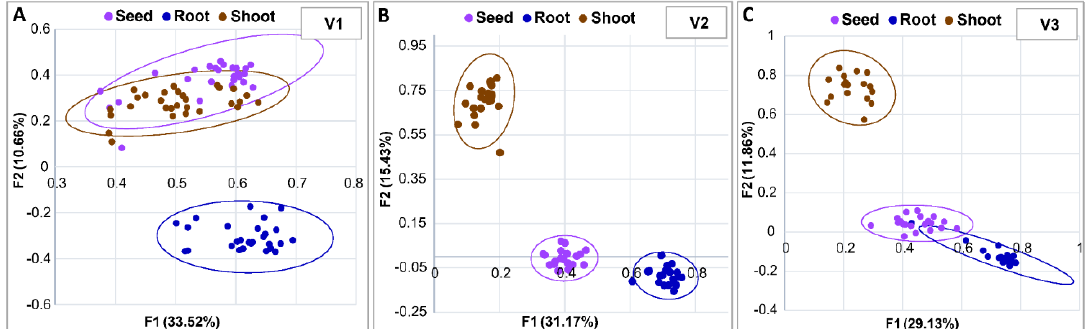
Figure 3. PCA biplots of microbial profiles of seed size categories (small, medium, and large), tissue types (seed, shoot and root), and varieties (V1, V2, V3) tested in this study generated using terminal restriction fragment length polymorphism (TRFLP). ( A ) Microbial profile of seed, root, and shoot in Variety 1; ( B ) Microbial profile of seed, root and shoot in Variety 2; ( C ) Microbial profile of seed, root and shoot in Variety 3. Nonoverlapping circles are statistically significant at 95% confidence level ( p < 0.05) according to Bartlett’s sphericity test. The further the distances between circles, the stronger the differences between the communities.